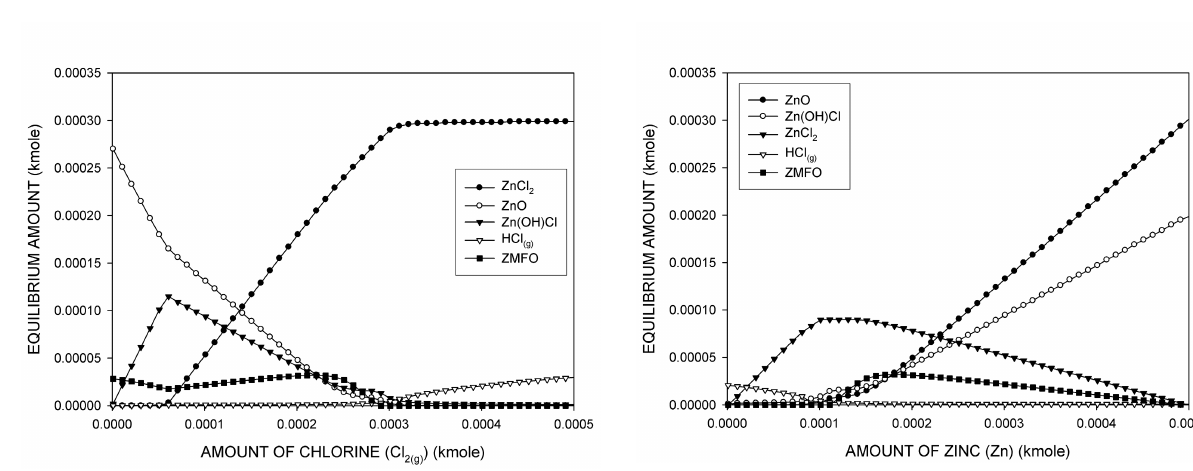
Figure 3(c). Effect of the amount of zinc on the equilib- rium amounts of the zinc-containing species and gaseous HCl for the Zn-Fe-Mn-O-H-C-Cl system.